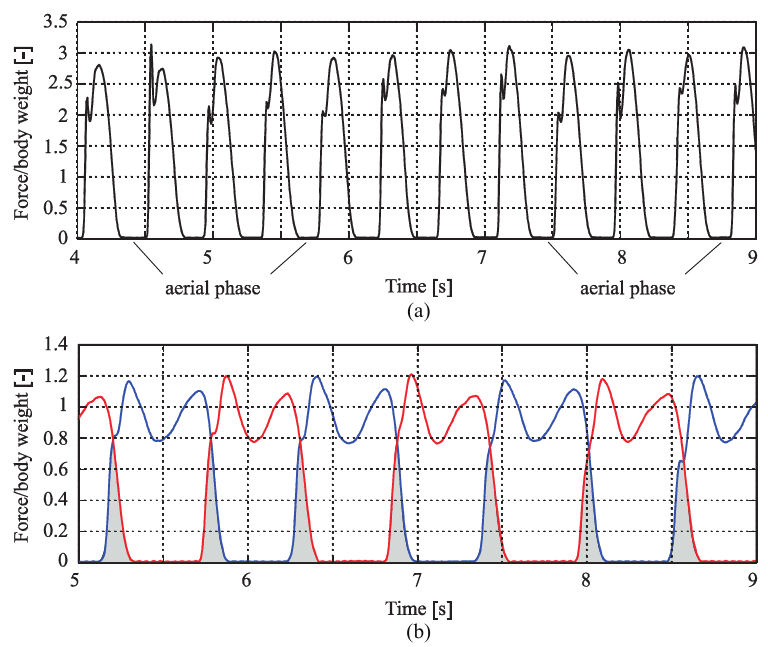
Fig. 8. Time-varying vertical GRF due to (a) running and (b) walking; the red and blue signals correspond to the left- and right-foot GRF, whereas the shaded areas represent double support